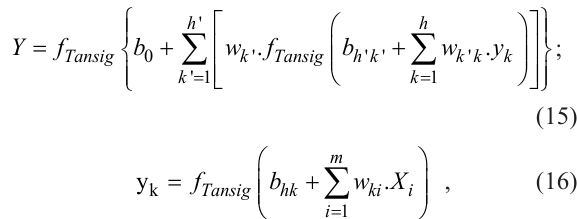
Table 6. Performance of ANN model against available SPT-based methods and some computing intelligent models Best fit calculations Arithmetic calculations